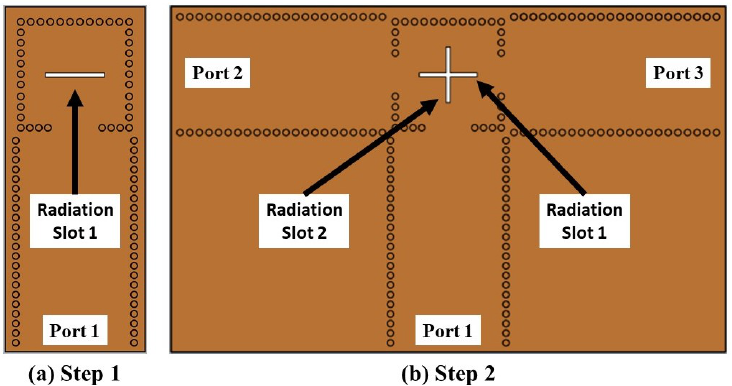
Figure 3. Design evolution of SIW antenna, ( a ) design of cavity, single-ended feed and radiation slot 1, ( b ) design of differential feed and radiation slot 2.